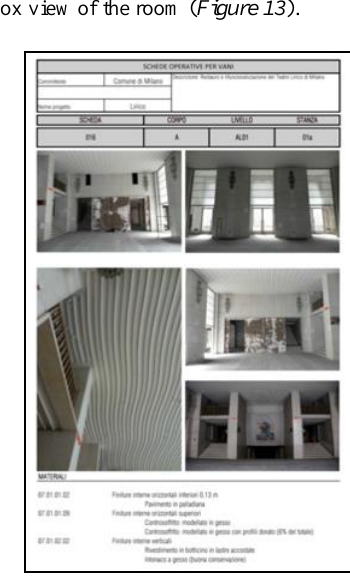
Figure 12. Example of operative table for room